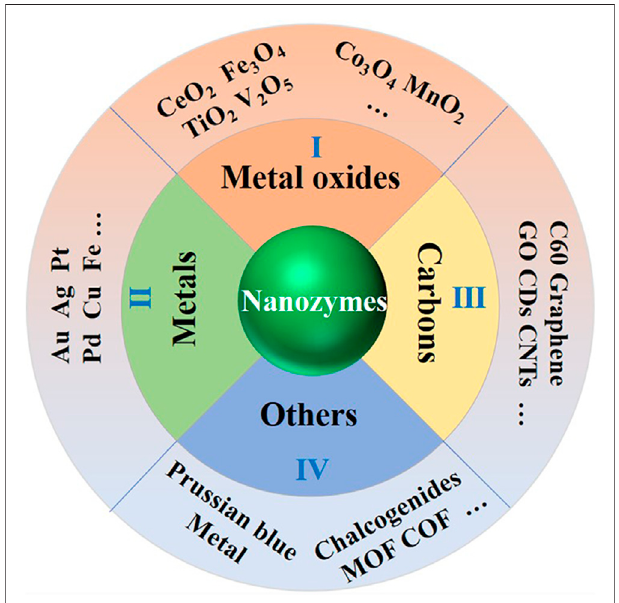
FIGURE 4 | Schematic presentation of nanozymes classi fi cations (metal-, metal oxide-, and carbon-based nanozymes and other nanozymes like MOF, COF,